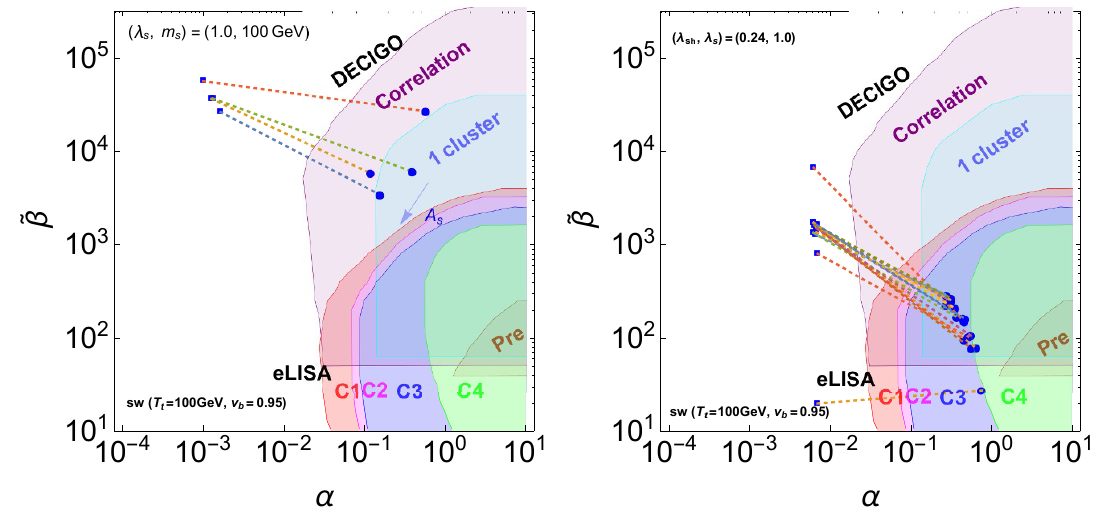
Figure 9 . Detectability of twin GW sources from the three-step ((cid:12)rst-second-(cid:12)rst order) PT pattern ((cid:10) 0 ! (cid:10) s ! (cid:10) sh ! (cid:10) h ) in the ( (cid:11) , e (cid:12) ) plane. For each point, the two sources of the (cid:12)rst order phase transition from the other (cid:12)rst order PT ((cid:10) 0 ! (cid:10) s ) and the (cid:12)rst order EWPT ((cid:10) sh ! (cid:10) h ) are labelled respectively by the square and circle points, connected by a dashed line. (Left panel for (cid:17) > 0): scanning points of (cid:21) sh and (cid:17) are plotted for the example ( (cid:21) s ; m s [GeV]) = (1 : 0 ; 100) which corresponds to a red point in (cid:12)gure 8 (right). (Right panel for (cid:17) < 0): scanning points of m s and (cid:17) are plotted for the example ( (cid:21) sh ; (cid:21) s ) = (0 : 24 ; 1 : 0) which corresponds to plots in (cid:12)gure 6 and a red point in (cid:12)gure 8 (left). The expected experimental sensitivities of eLISA and DECIGO are set by using the sound wave contribution for T (cid:3) = 100 GeV and v b = 0 : 95. (cid:15) Sound waves & MHD turbulence. Both are due to bulk motion, giving c = 2 : 65 (cid:2) 10 (cid:0) 6 [3 : 35 (cid:2) 10 (cid:0) 4 ], n = 1[1], r = 2[3 = 2] and f ( v ) = v [ v ], respectively [94{96]. b b b